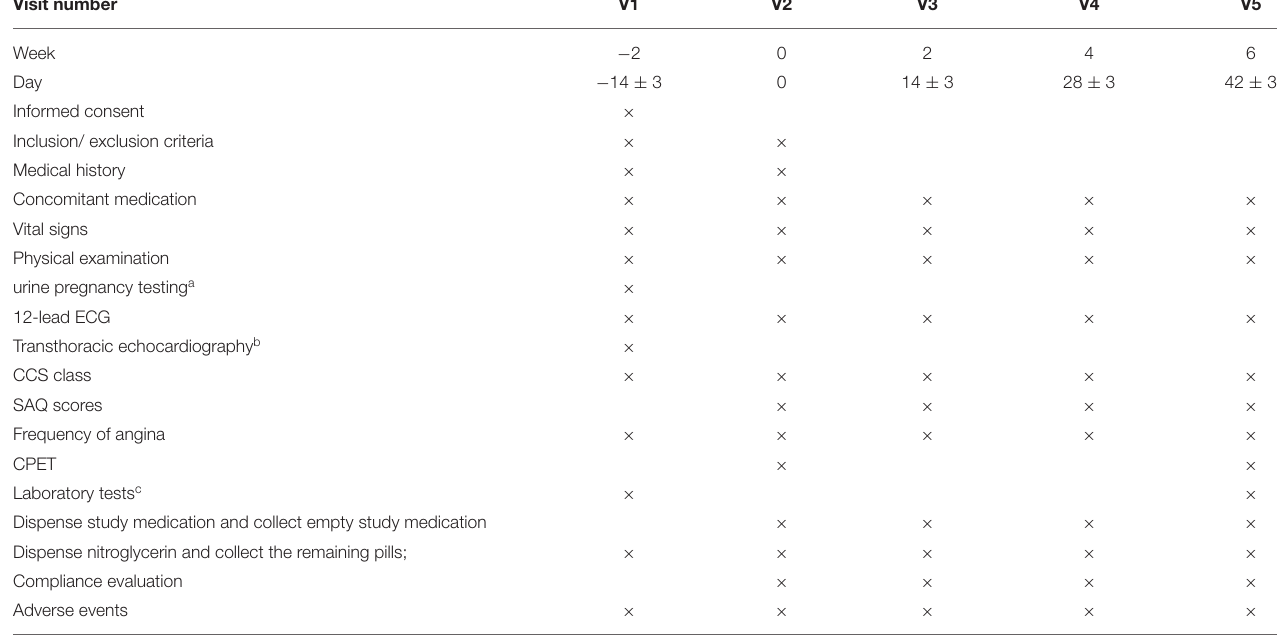
TABLE 3 | Schedule of